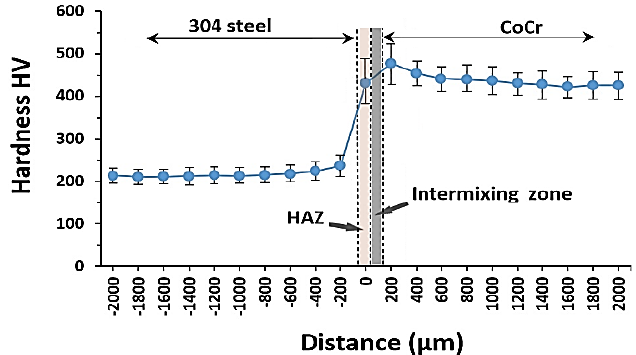
Figure 16. Vickers hardness of the CoCr – 304 steel interface.